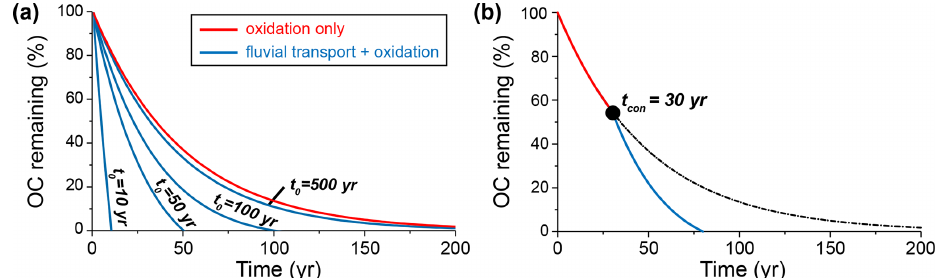
Figure 2. The fate of landslide-mobilized OC considered in terms of the proportion of the mass of OC remaining within a single landslide deposit as a function of time. (a) An example of a connected landslide for which the OC decrease is due to physical export and oxidation acting simultaneously (blue lines). The impact of the evacuation time is shown here by different values of t 0 (in years). The case of OC oxidation alone, with no physical export, is represented by the red line. (b) An example of a landslide deposit that is initially disconnected from the river network and that connects after a connection time, t con = 30 years, and is exported over a duration of t 0 = 50 years. The dotted ride line represents the OC oxidation